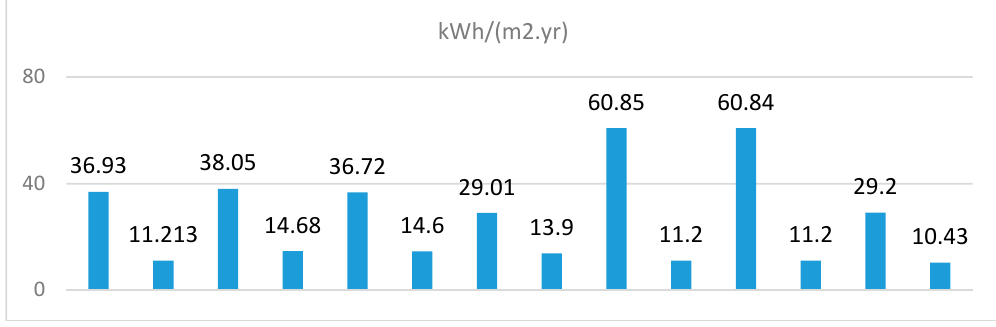
Figure 5. Monthly load/discomfort analysis for individual functions (without louvers).